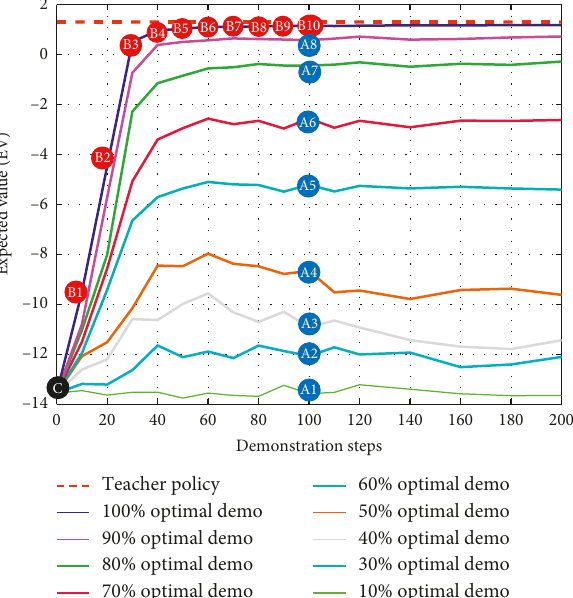
Figure 3: Performance of the standard IRL method (MLIRL) used in the first stage of our framework. The plain curves are the mean of “EV” scores with respect to demonstration steps and nonoptimality degree. The blue, red, and black circles are different initialization settings for stage 2 of our framework.